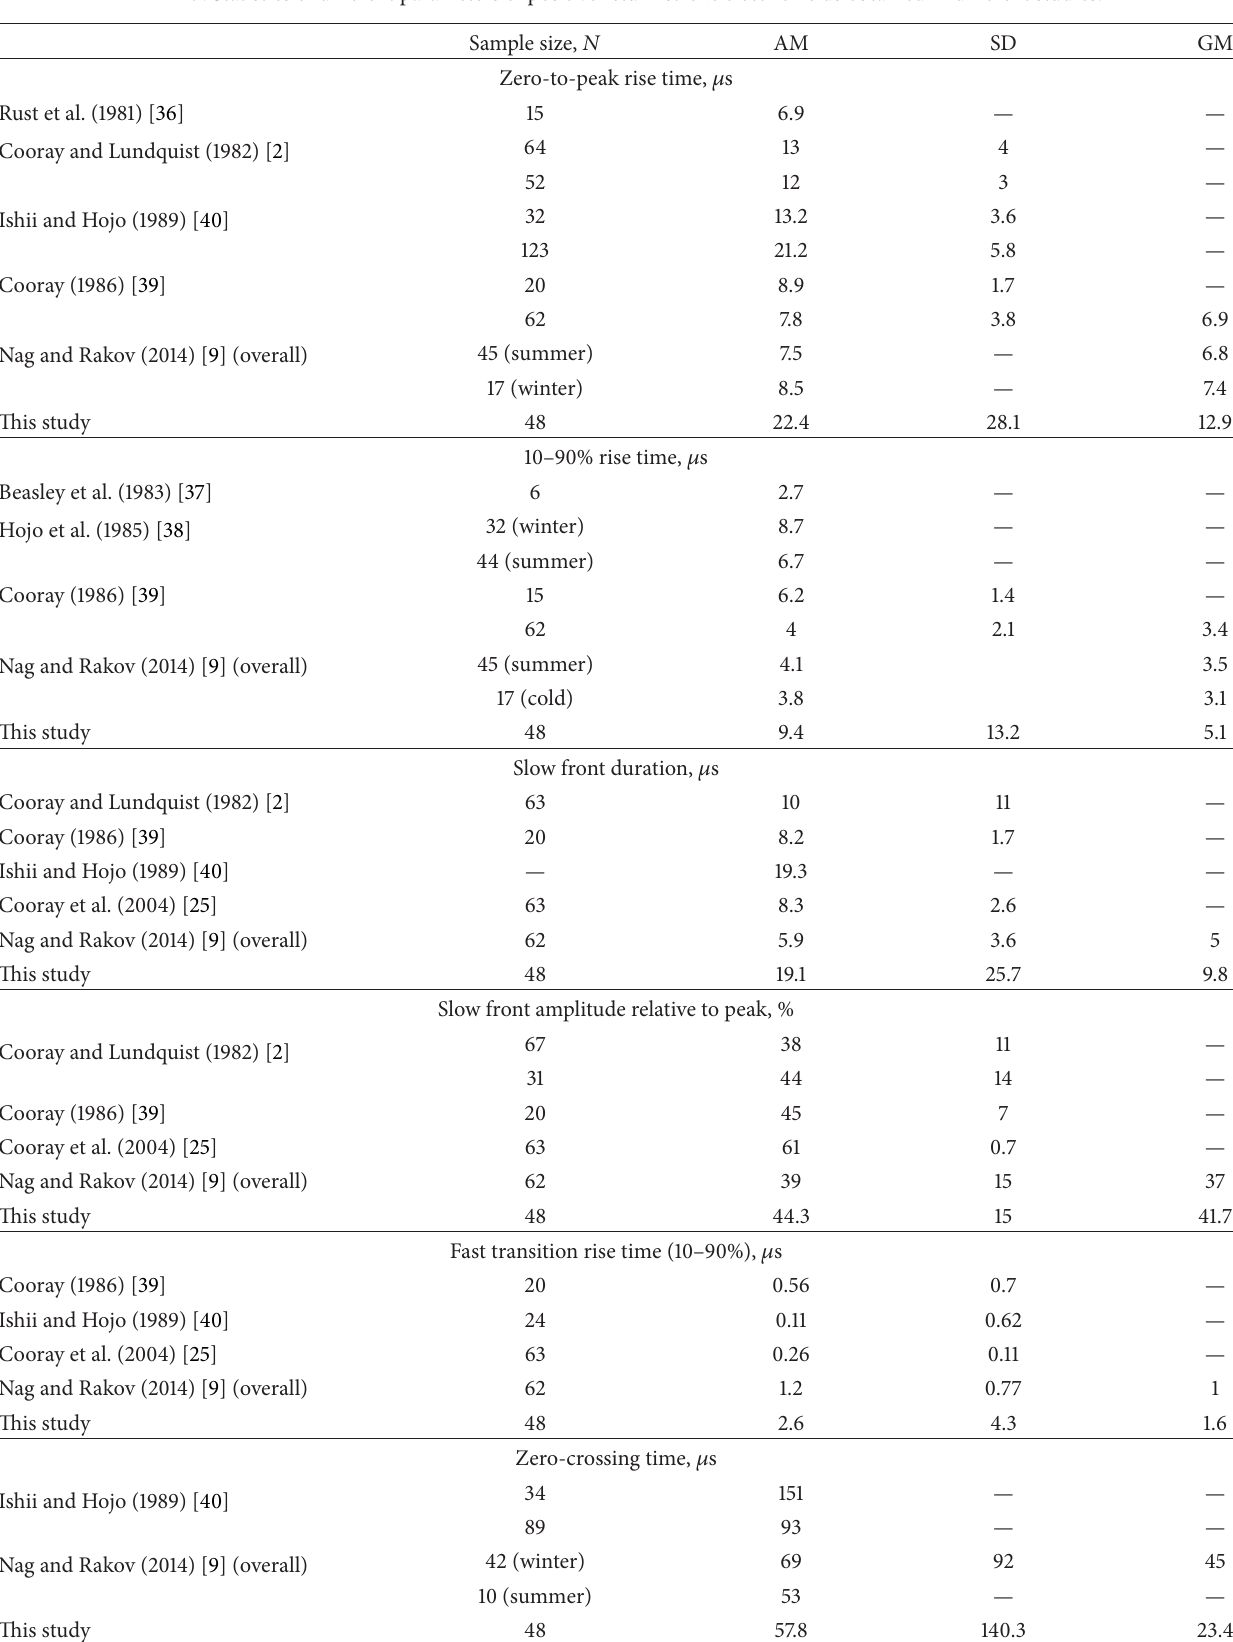
Table 7: Statistics of different parameters of positive return stroke electric fields obtained in different